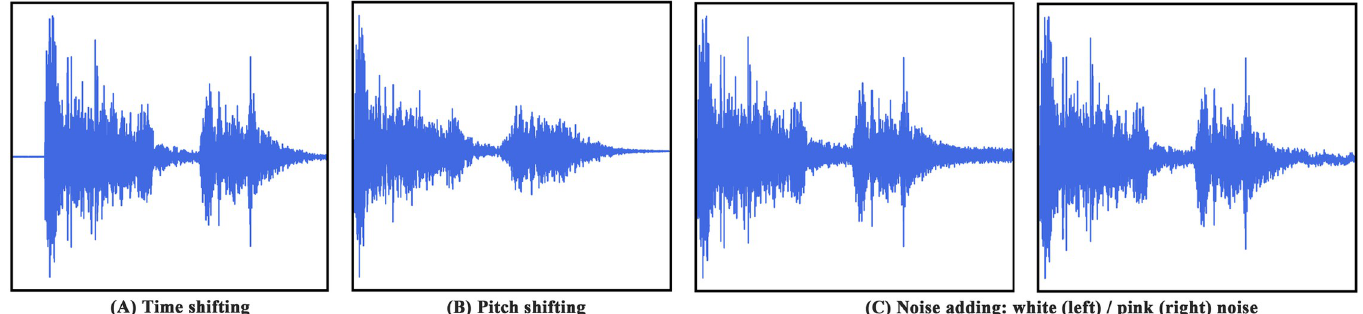
Fig 6. Waveforms of the cough chunks under three data augmentation